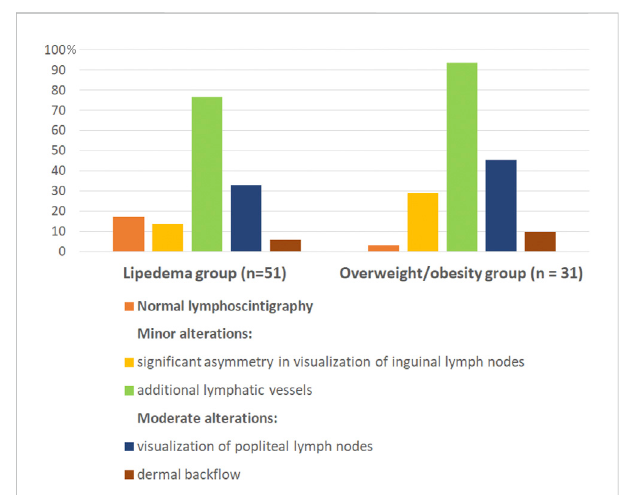
FIGURE 2 Graphically presented lymphoscintigraphic alterations in the studygroups.Lipedemaandoverweight/obesitygroupdidnotdifferin the type of lymphoscitigraphic alterations. Differences in percentages of individual lymphoscitigraphic alterations between the two groups were not statistically signi fi cant. All lymphoscitigraphic alterations in both study groups were of minor or moderate